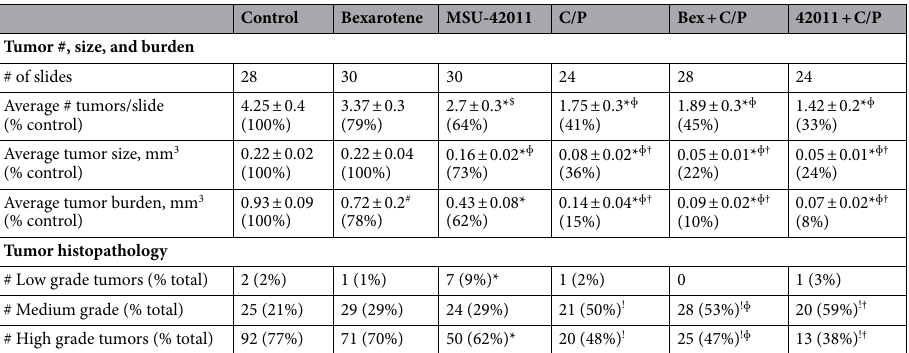
Table 2. MSU-42011 decreases the number and size of lung tumors when used to treat established lung tumors in A/J mice. Female A/J mice were injected with 2 doses of vinyl carbamate (0.32 mg/injection), 1 week apart, to initiate lung carcinogenesis. After 8 weeks, mice were fed either control AIN-93G diet or rexinoids in the same diet (100 mg/kg diet or ~ 25 mg/kg body weight). One week after diets started, mice were injected i.p. every other week for a total of 6 injections with carboplatin (C—50 mg/kg) and paclitaxel (P—15 m/kg). After 12 weeks on diet, lungs were harvested and processed for sectioning and H & E staining. Values shown are mean ± SE. *, p < 0.05 vs. control; ɸ , p < 0.05 vs. bexarotene; †, p < 0.05 vs. MSU-42011; #, p = 0.076 vs. 42011; !, p < 0.001 vs. control; $, p = 0.114 vs bexarotene.